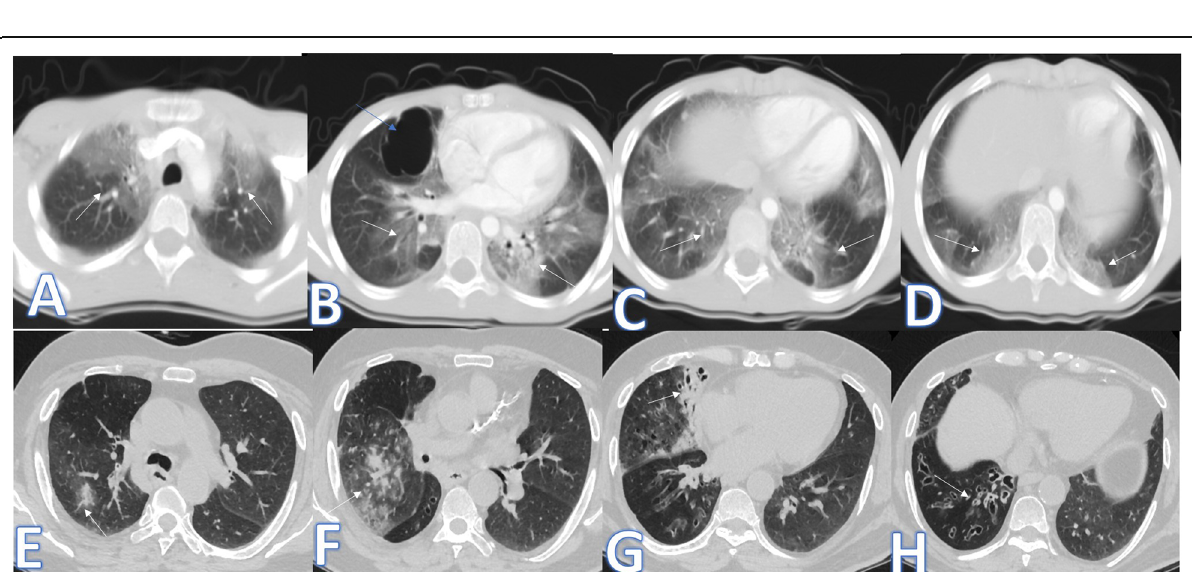
Fig. 1 A 10-year-old male patient with fever and cough. CT ( a – d ) showed bilateral scattered ground glass patches more central than peripheral (white arrows) with large pneumatocele at the medial segment of the right middle lobe (blue arrow). The diagnosis was staph pneumonia. A 45- year-old male patient with cough and fever. CT ( e – h ) showed unilateral right lung consolidative patch with tree-in bud appearance and ground glass appearance (arrows in e and f ) with cylindrical bronchiectasis at the middle and lower lobes (arrows in g and h ) and peribronchial thickening. The diagnosis was bacterial